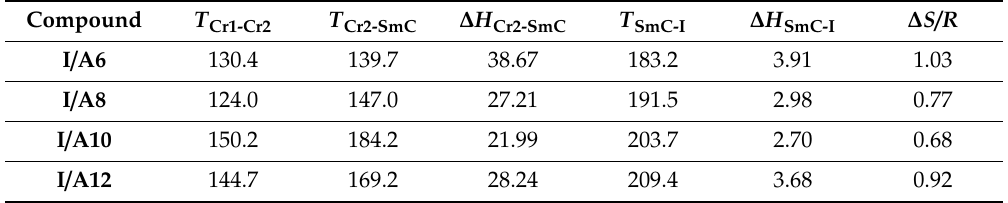
Figure 7. Polarizing optical microscopy (POM) smectic C (SmC) phase texture upon heating for 2:1 supramolecular complex: ( a ) I / A8 at 185 o C and ( b ) I / A12 at 197 o C. Table 3. Phase transition temperatures ( ◦ C), enthalpy of transitions (kJ / mol), and normalized transition entropy of supramolecular H-bonded complexes I / An